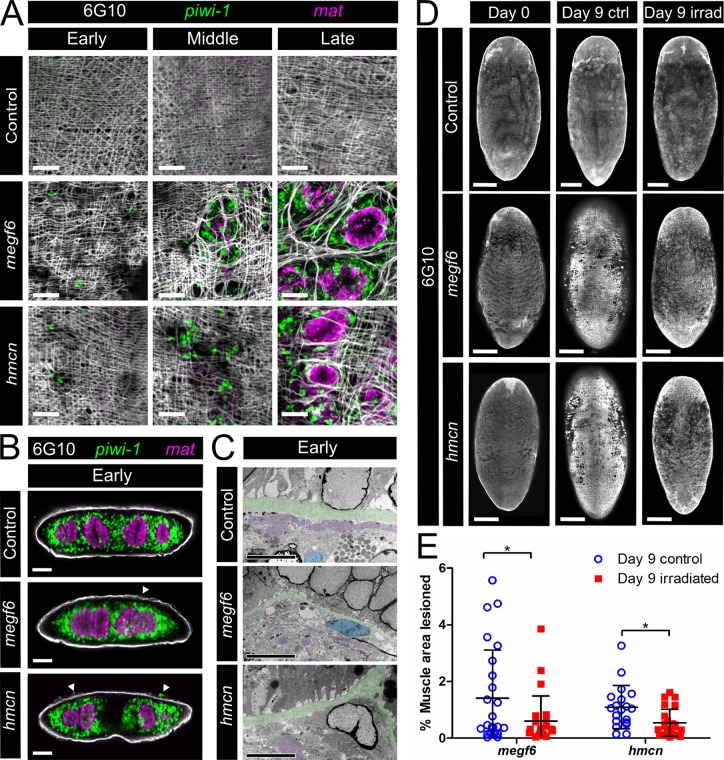
Development of the megf6 and hemicentin knockdown phenotypes.A) Timepoints during the progression of the megf6 and hemicentin knockdown phenotypes, shown by double FISH for piwi-1 and mat and 6G10 staining (n ≥ 8). All worms were fixed 3 days after the last RNAi feeding: 5 feeds for the early phenotype, 7 feeds for the middle, and 9 feeds for the late. B) Transverse cross-sections of planarians from the early (5fd3) timepoint, stained with mat, piwi-1, and 6G10 (n = 3). White arrowheads denote piwi-1 cells above the muscle layer. C) Transmission electron microscopy images of planarians from the early timepoint (n = 3). The basement membrane is coloured green, subepidermal nuclei are blue, and muscle fibers are purple. D) Confocal extended focus images showing the body wall muscle of control, megf6, and hemicentin knockdown planarians. Day 0 animals were fixed 3 days after the 4th RNAi feed. At this timepoint, half of the remaining worms were given a lethal dose of irradiation. 9 days later, both irradiated and non-irradiated control worms were fixed and all worms were stained with 6G10 antibody. E) Quantification of lesioned area in worms from D), shown as percentage of total muscle area (n ≥ 19). Lesions were quantified relative to controls. Scale bars: 100 μm in A, B; 5 μm in C; 250 μm in D. Error bars are standard deviations. *p < 0.05 (Welch’s t-test).